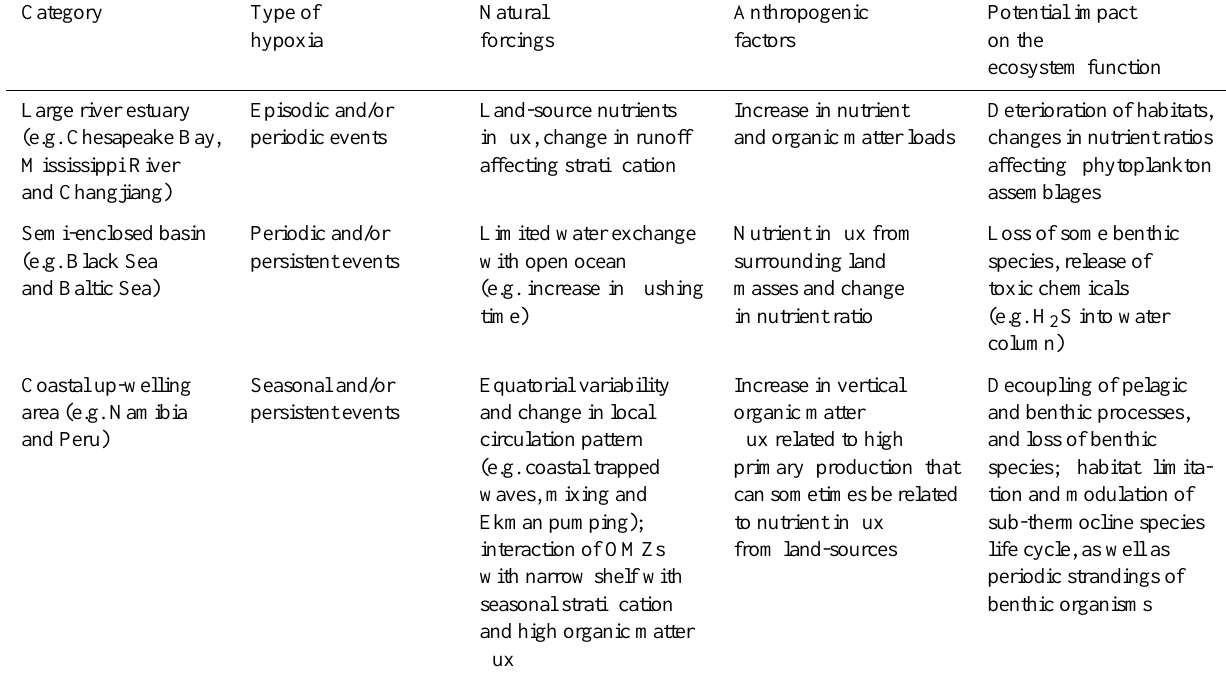
Table 3. Summary of major types of coastal ecosystems affected by hypoxia with different natural and anthropogenic driving forces.